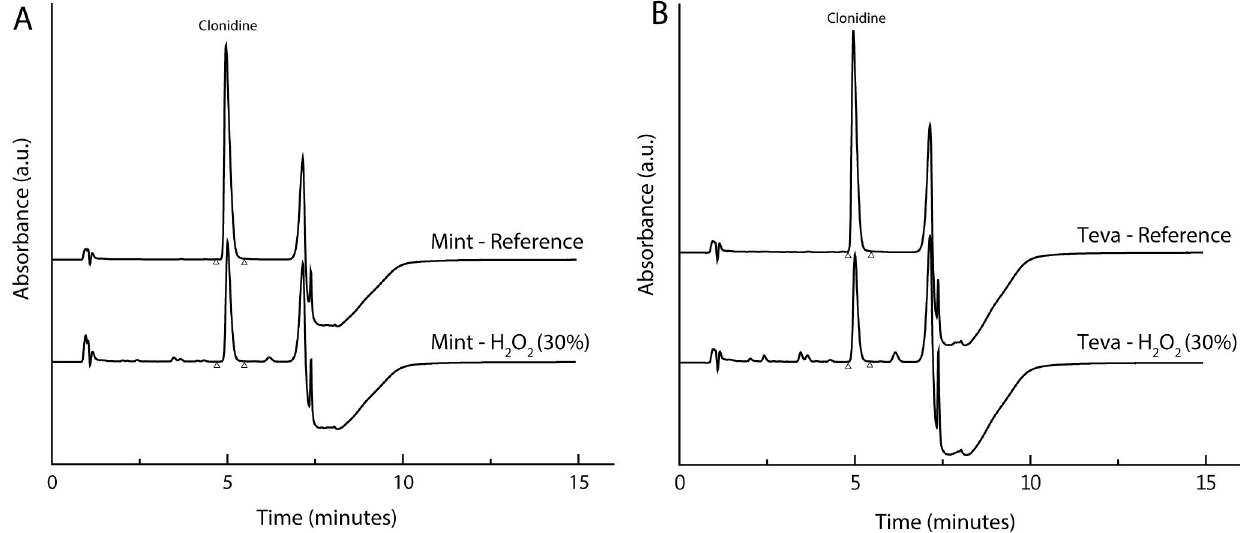
Fig 3. Representative chromatograms of clonidine hydrochloride degradation in oral liquids under extensive oxidizing conditions. Clonidine hydrochloride degradation under oxidative conditions with hydrogen peroxide (H 2 O 2 30%) for Mint (A) and Teva (B) oral liquids after 24 h at 60˚C compared to their respective